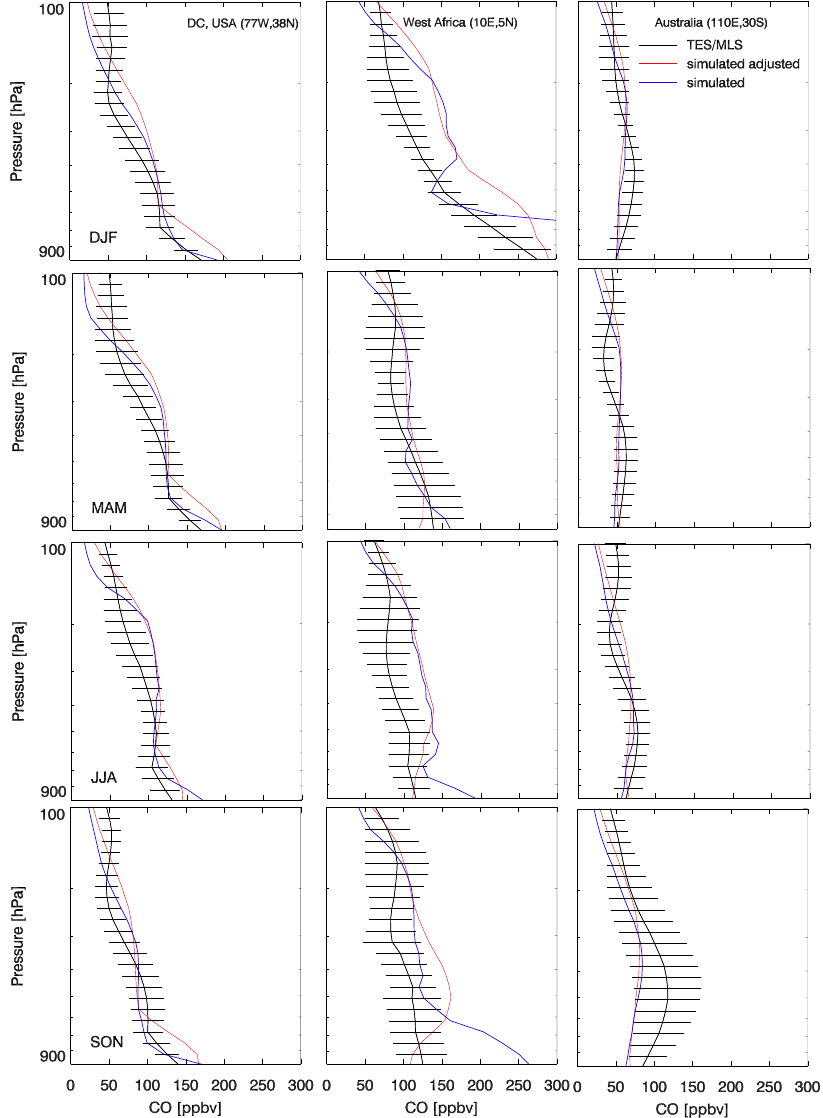
Figure 13. Seasonal mean (2006–2007) CO vertical profiles (ppbv) over select locations of TES/MLS data, the Base scenario (“simulated”), and the Base scenario adjusted with averaging kernels (“simulated adjusted”). The horizontal bars represent the standard deviation of the individual overpasses used to create the seasonal